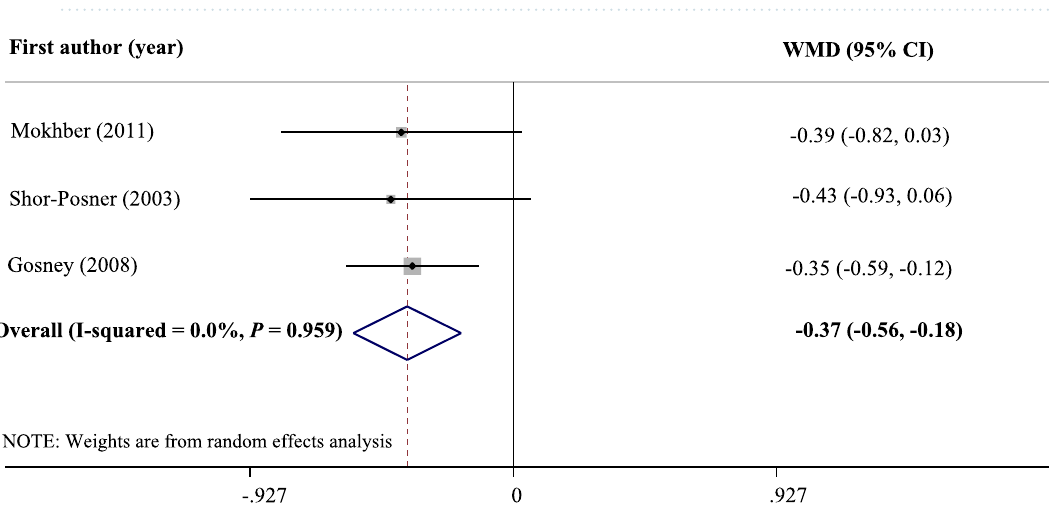
Figure 4. Forest plot of the association between selenium intake and the risk ratio of depression stratified by the type of depression.